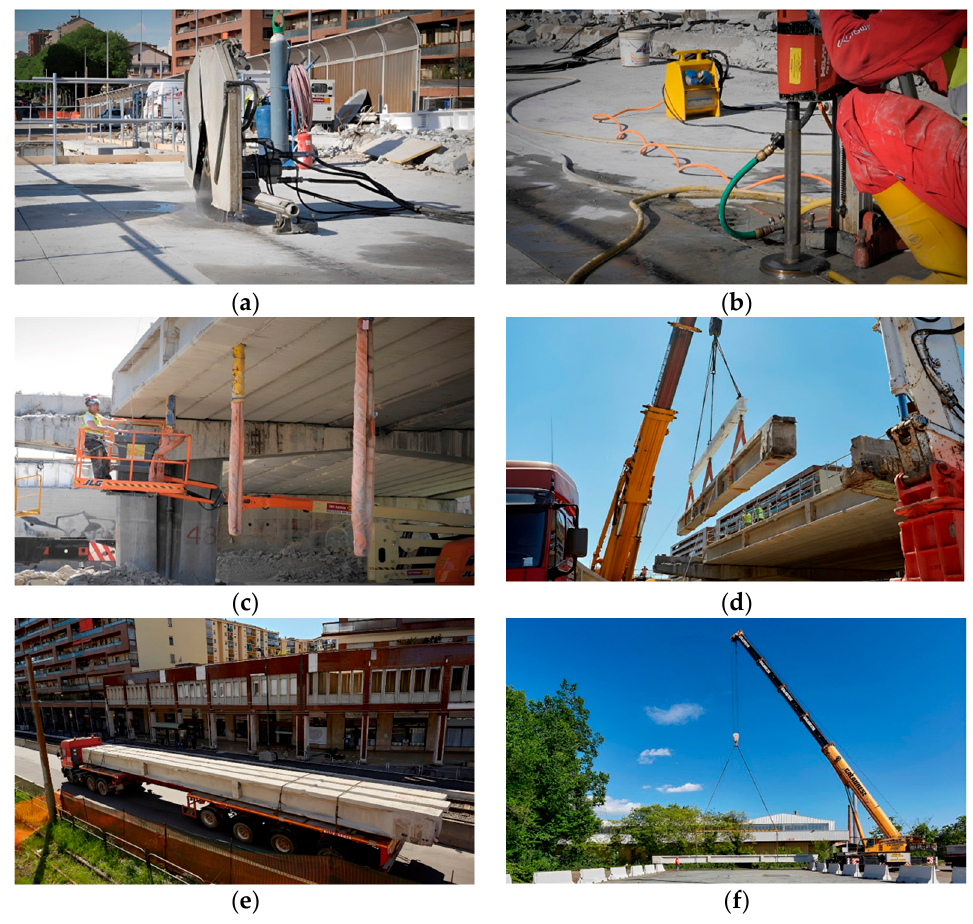
Figure 4. Deconstruction phases: ( a ) cutting; ( b ) drilling; ( c ) sling ropes; ( d ) lifting; ( e ) moving; ( f ) testing site setup.